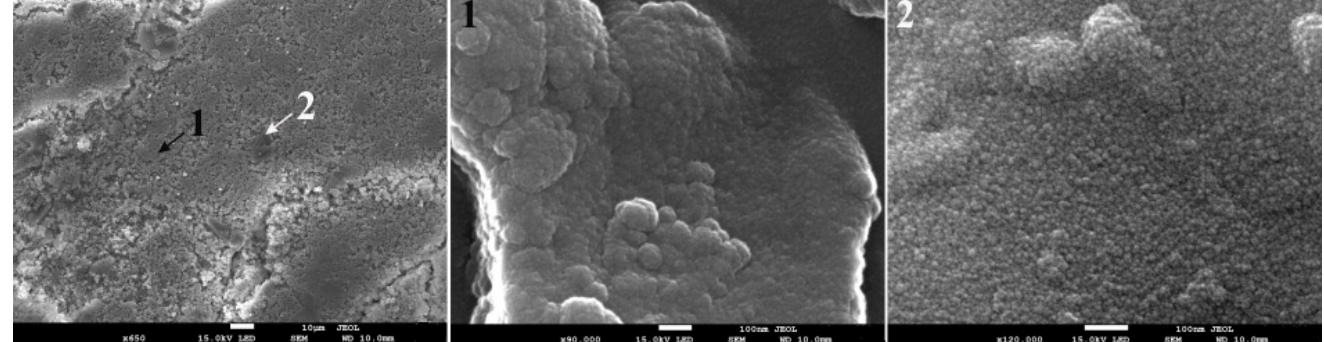
Figure 11. SEM images of the char produced at 603 K and 10 min residence time. High magnification images of the regions marked as 1 and 2 are displayed in the middle and the right panel respectively.